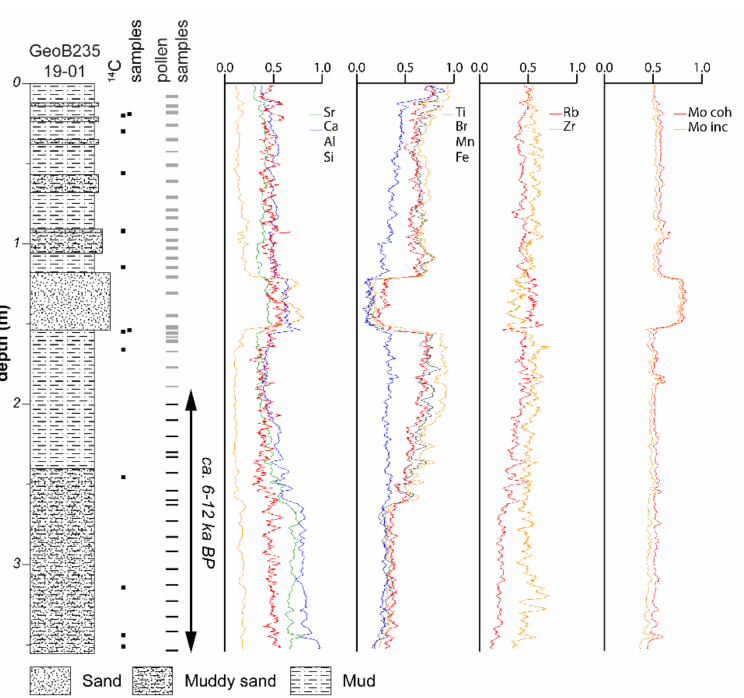
Figure 2. Lithological log, location of 14C and pollen samples (black: samples used in this study) and selected XRF parameters for core 19-01. Table 1. Radiocarbon samples and calibration parameters and results. * and italics: rejected sample due to possible reworking. Core Lab.